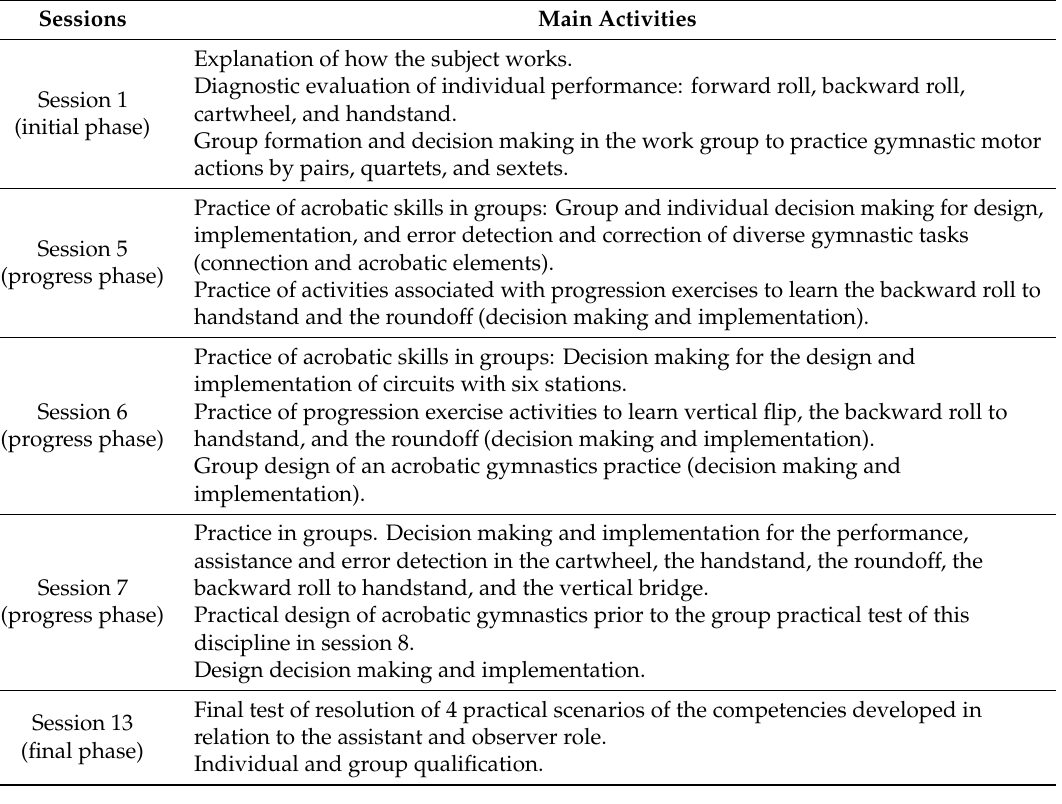
Table 1. Contents developed in the sessions of the analyzed gymnastic